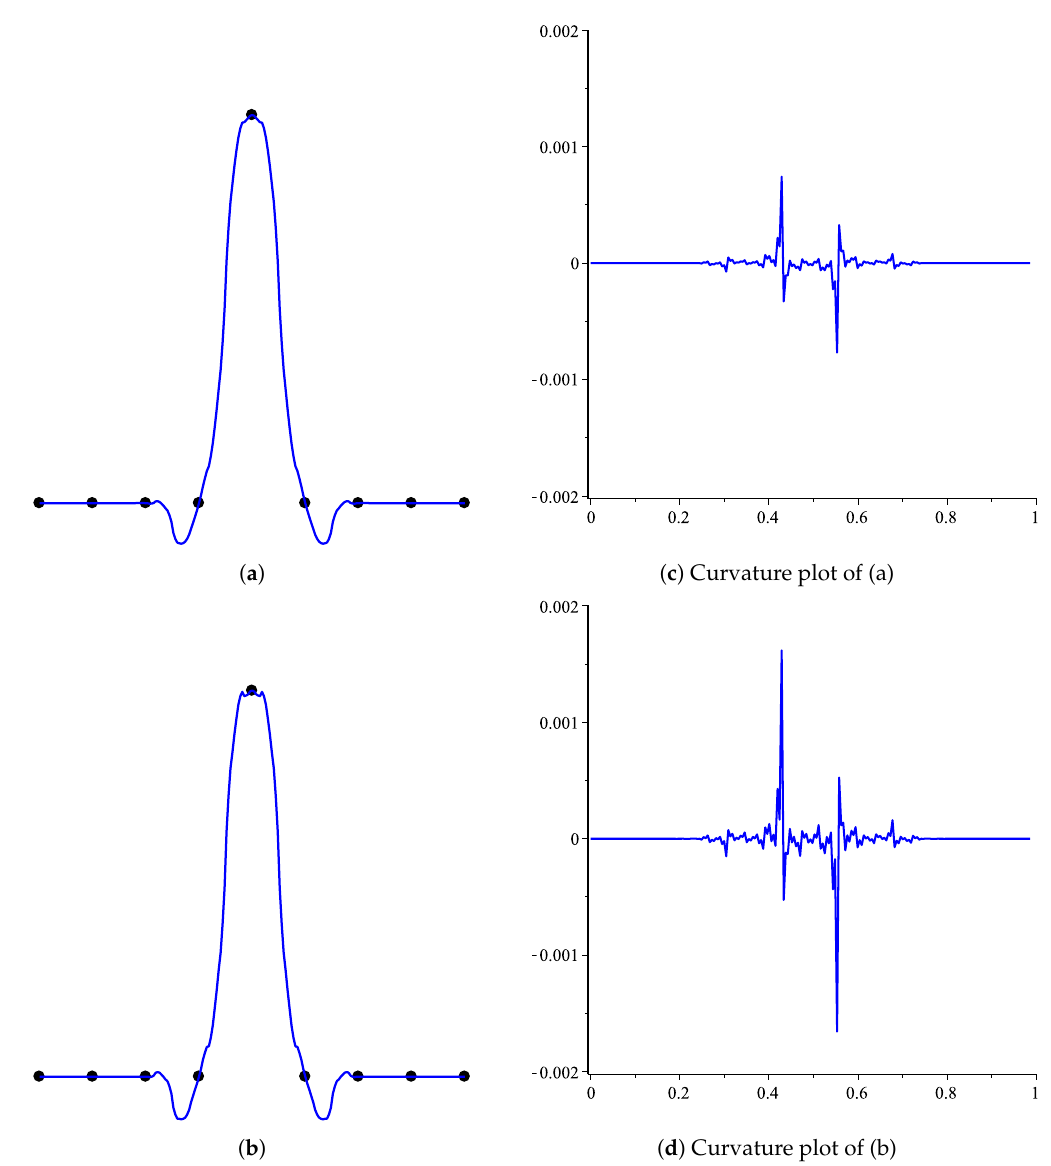
Figure 6. Results for various choices of the parameter u are shown on the left together with their corresponding curvature on the right. From top to bottom: u = 0.0076 and 0.0077. ( a ) Limit curve at u = 0.0076; ( b ) Limit curve at u = 0.0077; ( c ) Curvature plot of ( a ); ( d ) Curvature plot of ( b